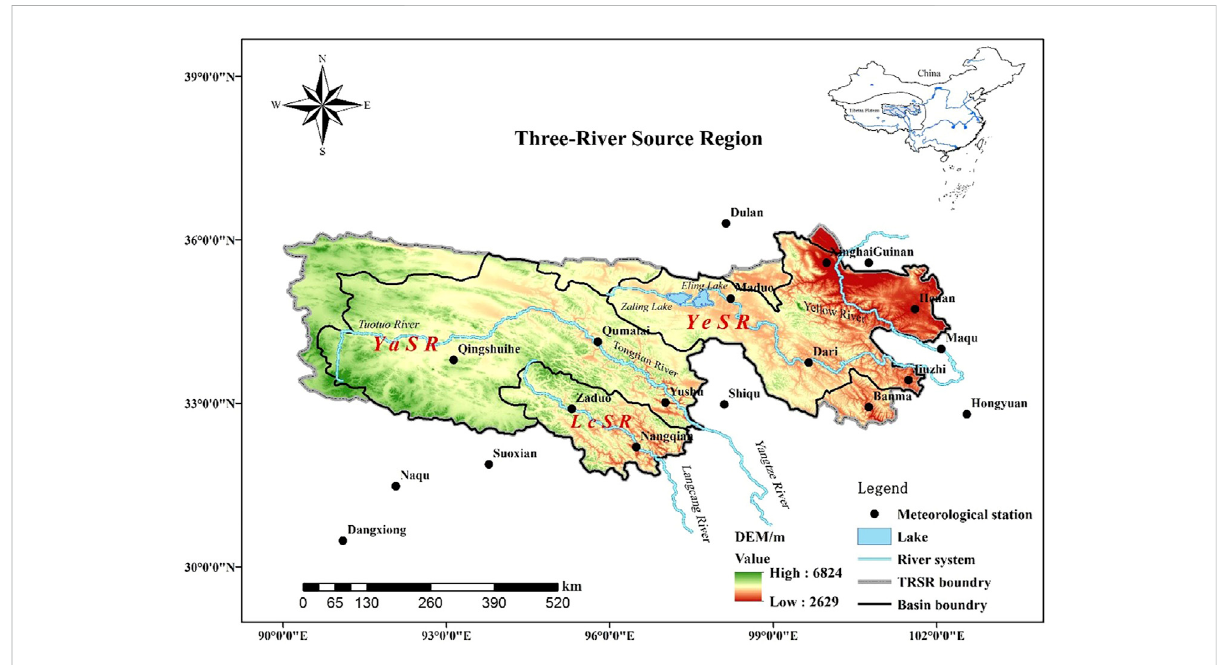
FIGURE 1 Geographical overview and spatial distribution of meteorological stations in the Three-River Source Region (TRSR) of Tibetan Plateau,